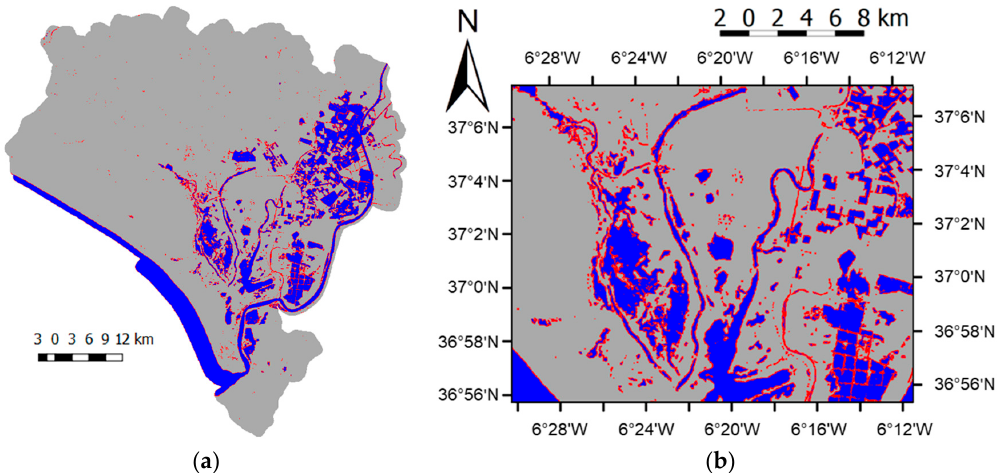
13. Figure 13. ( a ) Boundary regions (red pixels) between inundated areas (blue pixels) and non-inundated areas (gray pixels) in the Landsat inundation map on 6 June 2016; and ( b ) a zoomed region of this